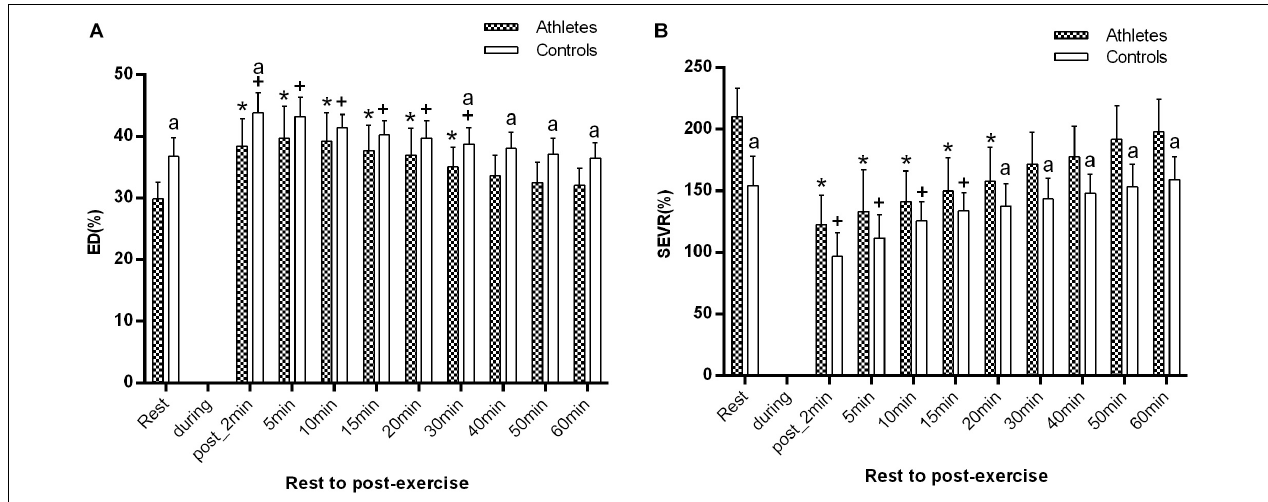
FIGURE 4 | The difference of ED (A) and SEVR (B) between the athletes and controls before and after exercise. The error bars represent the between-participant standard deviation ( SD ). The “ a ” indicates significant difference between the two groups with p < 0.05; The “*” and “ + ” indicate significant difference between pre- and post-exercise with p < 0.05 in athletes and controls, respectively.